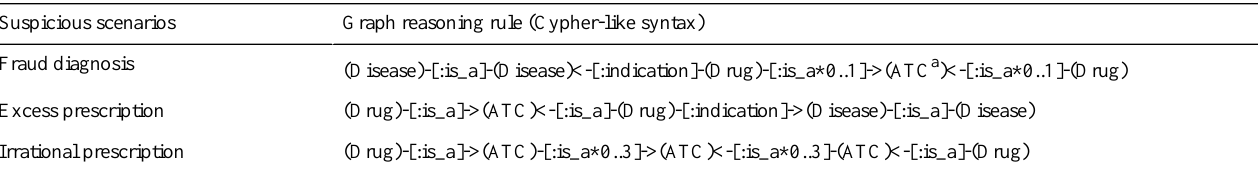
Table 6. Graph reasoning processing in Fraud, Waste, and Abuse detection.